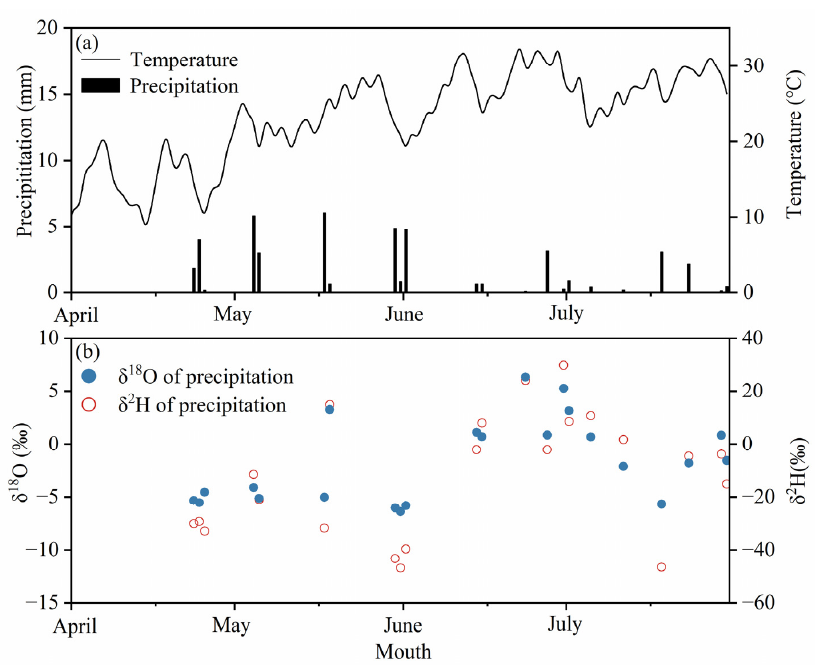
Figure 2. Changes of ( a ) daily precipitation and temperature in the study area, ( b ) isotope composi- tions in precipitation during the observation period from April to July 2022.